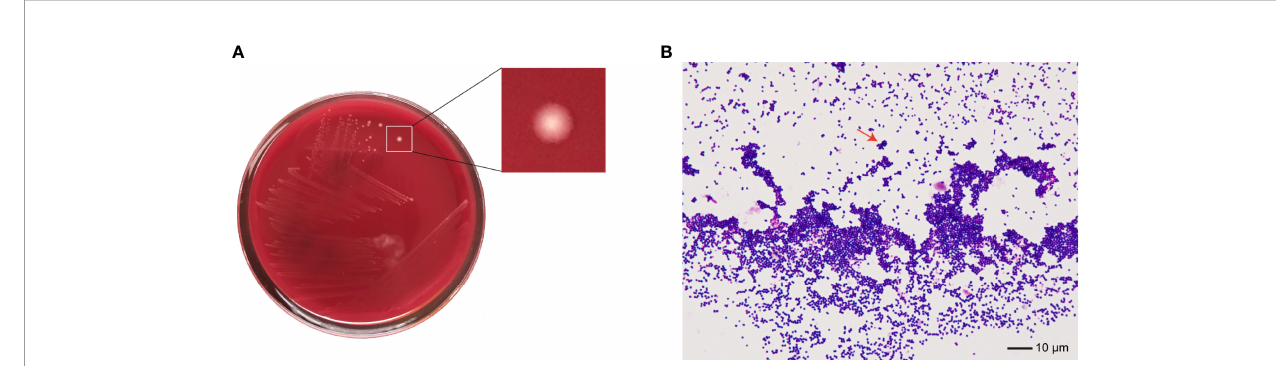
FIGURE 2 | The phenotype of SAHP1. (A) Bacterial colonies on the Columbia blood agar after 48 h of incubation under anaerobic conditions. (B) Gram staining of bacteria from a positive aerobic blood culture showed Gram-positive cocci (×1,000 magni fi cation)